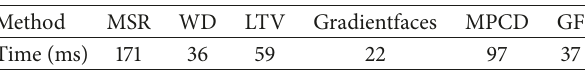
Table 3: Comparison on the run time of different illumination